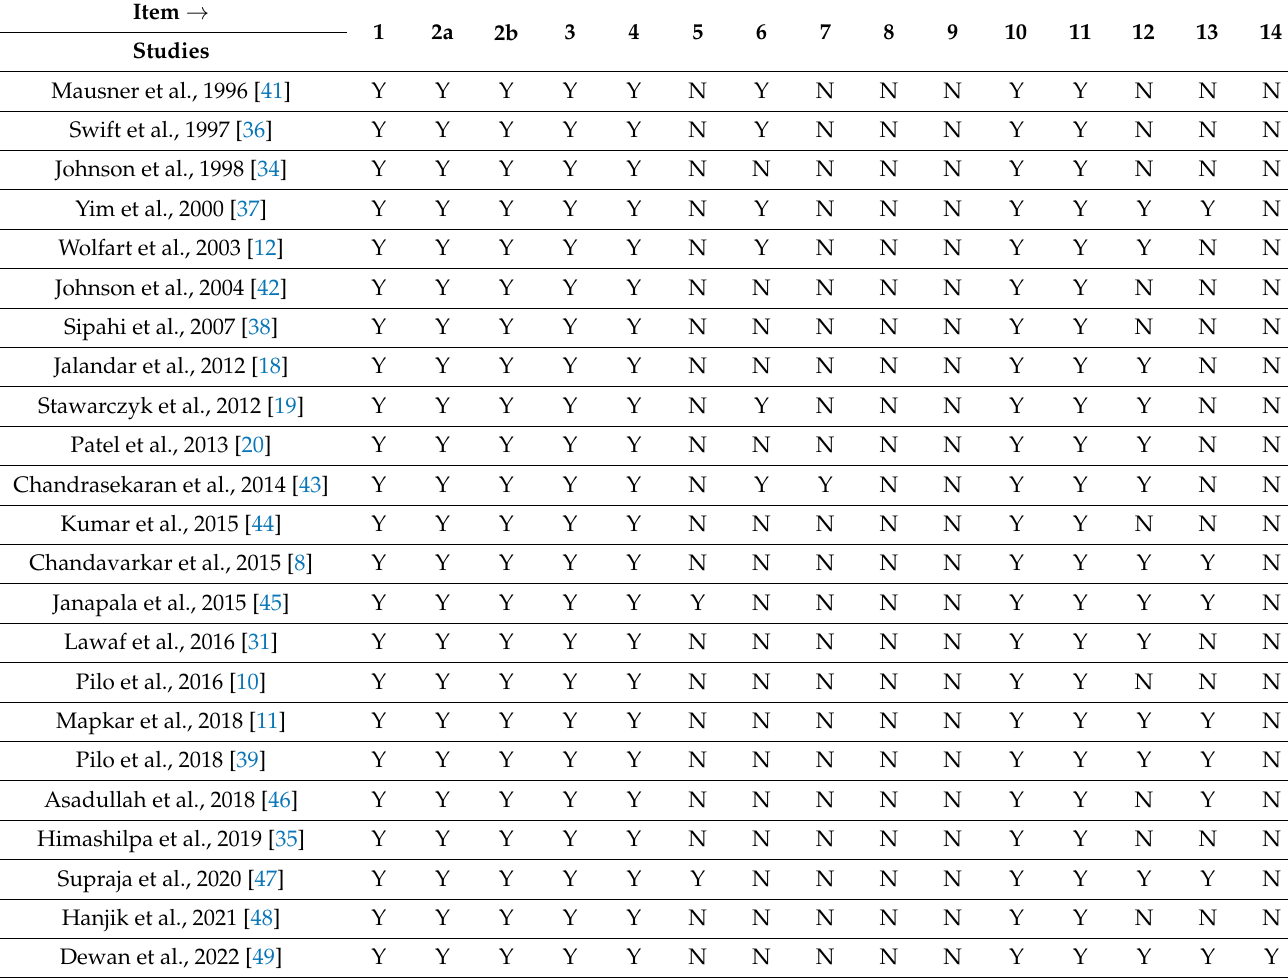
Table 2. Quality analyses of the included studies using the modified CONSORT scale.